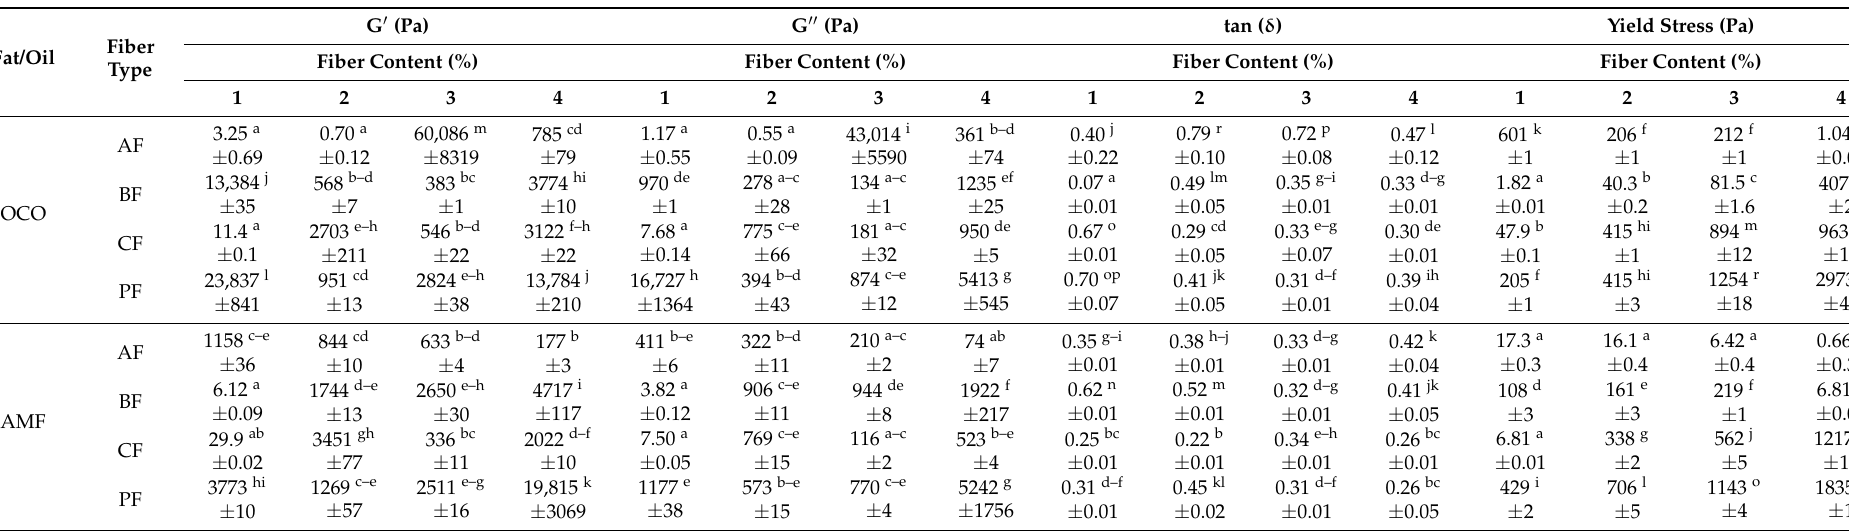
Table 2. Effect of different fibers concentration on PCS (processed cheese sauces) obtained on the basis of AC (acid casein) with OCO (organic coconut oil) or AC (acid casein) with AMF (anhydrous milk fat) on value of G (cid:48) and G (cid:48)(cid:48) moduli, tan ( δ ) and yield stress.